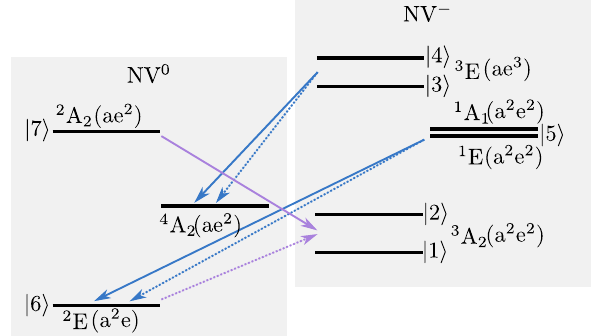
Figure 9: Electronic energy level scheme of the nitrogen-vacancy (NV) centre showing the ionisation and recombination processes that have been observed. Levels 1 – 5 belong to NV − and 6 and 7 belong to NV 0 and have been labelled with their corresponding molecularsymmetryassignmentsaswellastheirmolecularelectron orbital states. This picture shows that state 5 is in fact two distinct energy levels and there is also a spin quartet metastable state that plays a role in the ionisation dynamics. These states have been removed in Figure 4 as they do not signi fi cantly impact the rate equation description of the system. The blue arrows indicate ion- isation pathways from the NV − state to the NV 0 state, whereas the purple arrows indicate recombination pathways from NV 0 to NV − . The dashed arrows indicate tunnelling processes that are mediated by a nearby single substitutional nitrogen acting as a charge donor to the NV centre. The solid lines are photon-mediated processes. At this stage, it is uncertain if all of these photon-mediated processes are intrinsic to the NV centre or are due to ionisation of nearby charge donors leading to a tunnelling process. It is unlikely that ionisation from the 3 E ( ae 3 ) excited state of the NV − occurs directly to the 2 E ( a 2 e ) ground state of the NV 0 as this must involve a two- electron process. It is more likely that the transition occurs into the 4 A 2 ) metastable state of the NV 0 centre before quickly and 2 ( ae nonradiatively decaying into the ground state of the NV 0 . In the rate equation models used to simulate this system, these two processes are approximately equivalent. It is important to note that there may be additional allowed pathways for ionisation such as from the 3 E ( ae 3 ) excited state of the NV − into the 2 A 2 ) excited state of the 2 ( ae NV 0 that we have not considered in this paper.